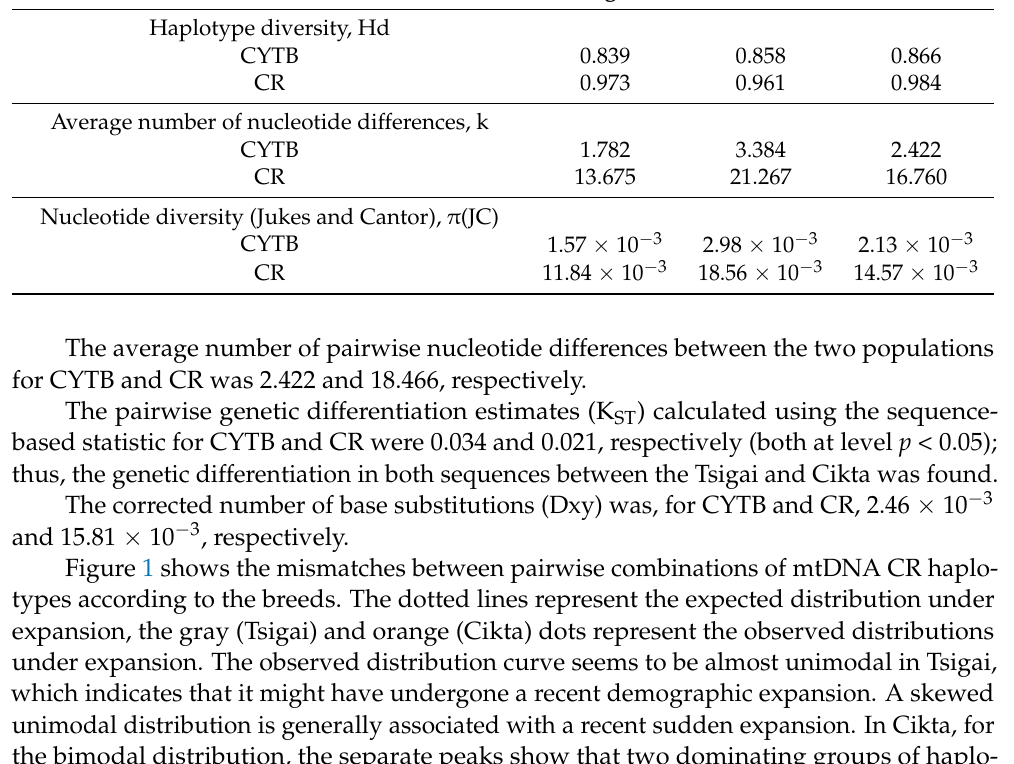
Table 1. Values of haplotype diversity, k and π (JC) according to breeds for CYTB and CR. Parameter Tsigai Cikta Total Haplotype diversity, Hd CYTB 0.839 0.858 0.866 CR 0.973 0.961 0.984 Average number of nucleotide differences, k CYTB 1.782 CR 13.675 16.760 Nucleotide diversity (Jukes and Cantor), π (JC)